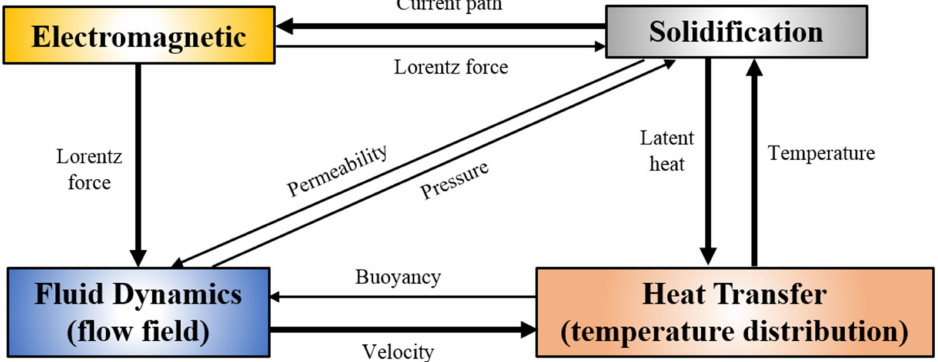
Figure 2. Coupled computational relationships for multiple physical fields during the VAR